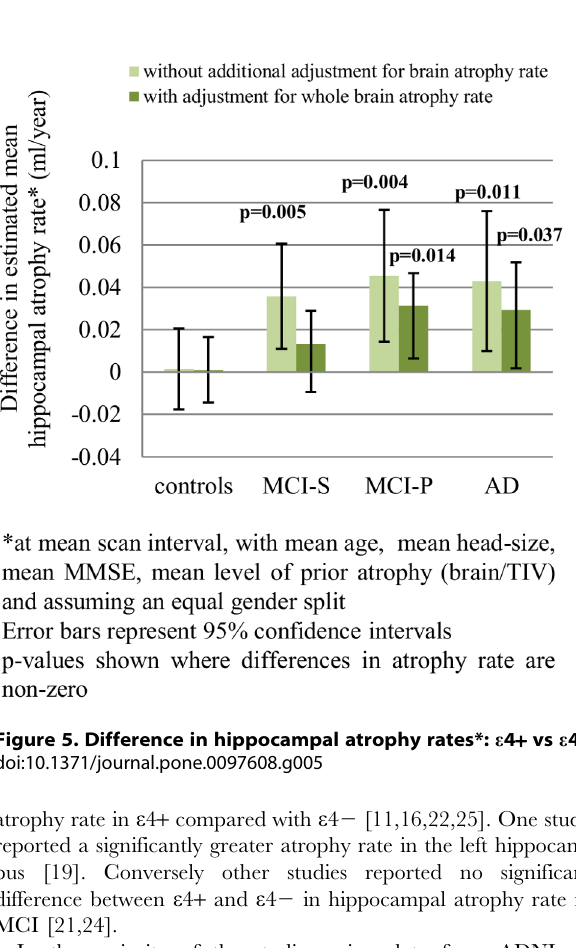
Table 3. Adjusted mean difference in whole-brain and hippocampal atrophy rate (ml) [95% CI] for e 4 carriers compared with non- carriers in controls, stable MCI, MCI progressors and AD ( + ve means atrophy rate is higher in e 4 + ).